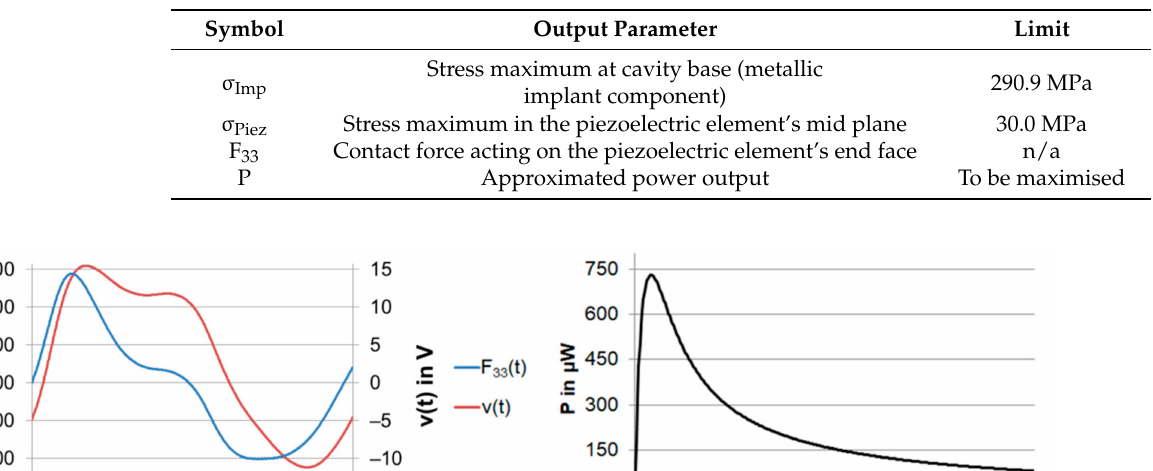
Table 3. Output parameters.